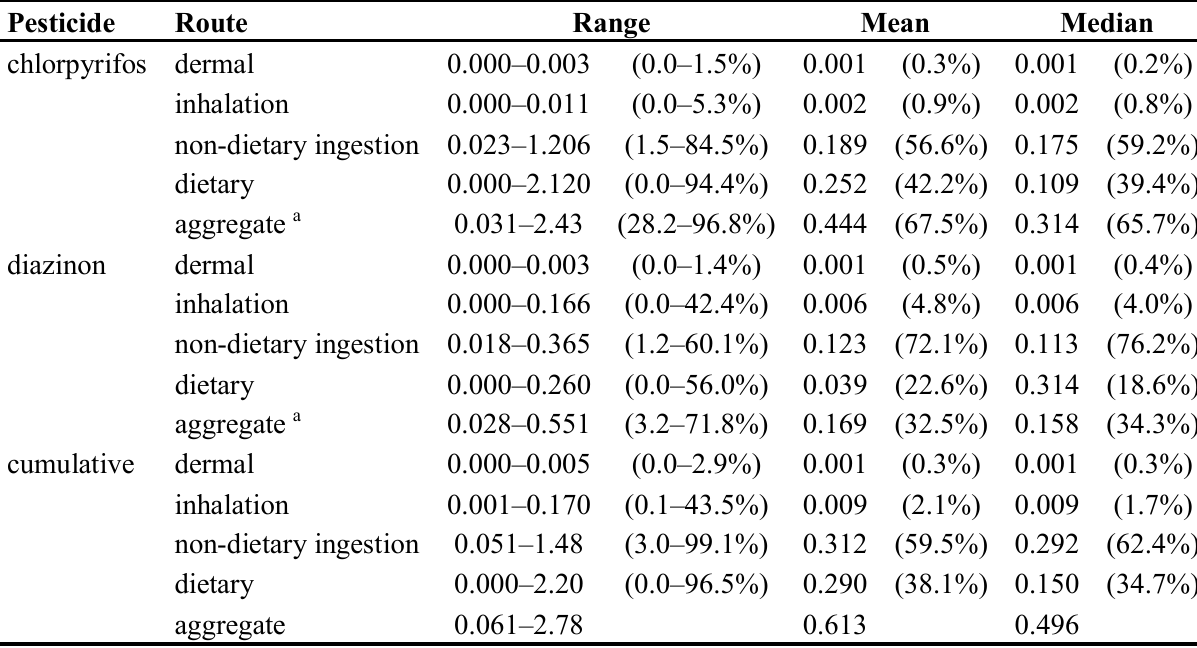
Table 6. Dose estimations (nmol/kg-day) for the farmworker children population ( n = 115,000) by pesticide and